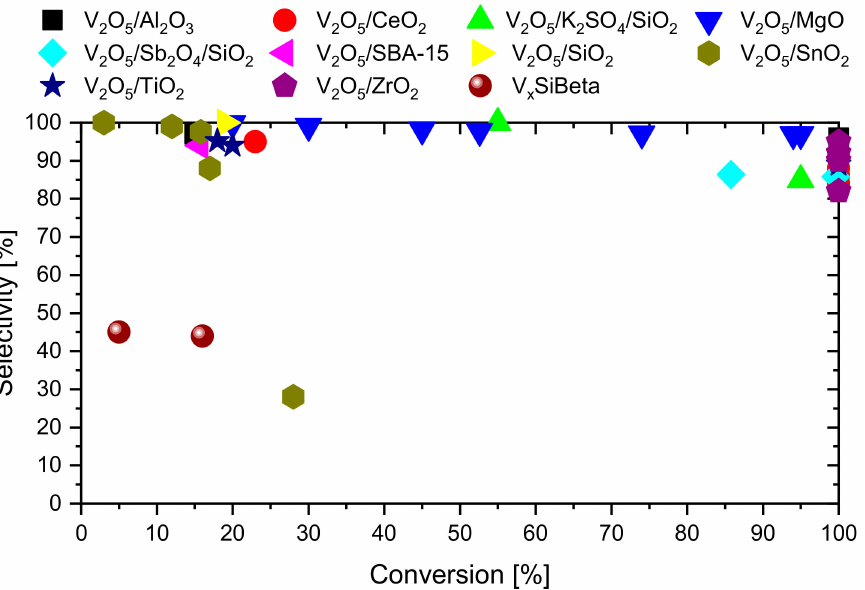
Figure 34. Summary of catalytic test results for V oxide catalysts in the literature shown as selectivity vs. conversion